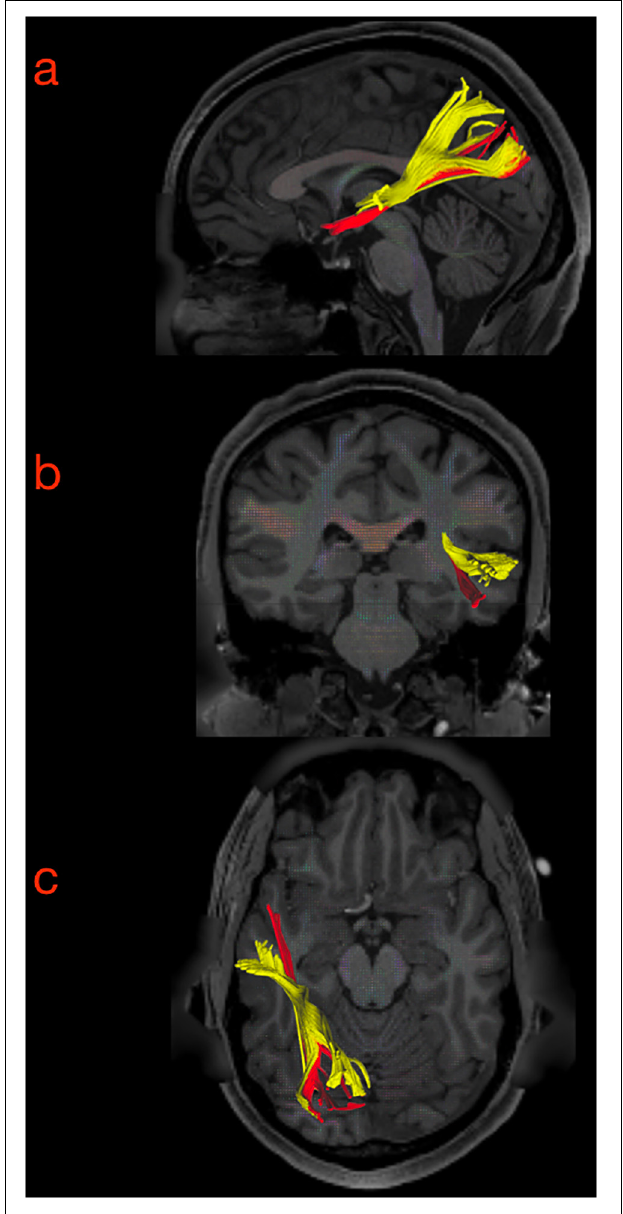
FIGURE 7 | Sagittal (a) , coronal (b), and axial (c) slice of the tractography reconstruction of the two MdLF components on the left-sided hemisphere (axial slice in neurological projection). In the temporal region, the subcomponents were clearly distinguished from the stem to their terminations. The anterior component (originating from the anterior portion of the superior temporal gyrus, aSTG, and planum polare, PP) was named the aMdLF (red). The posterior portion (originating from the posterior portion of superior temporal gyrus, pSTG, anterior temporal transverse gyrus, aTTG, and planum temporale, PT) was named the pMdLF